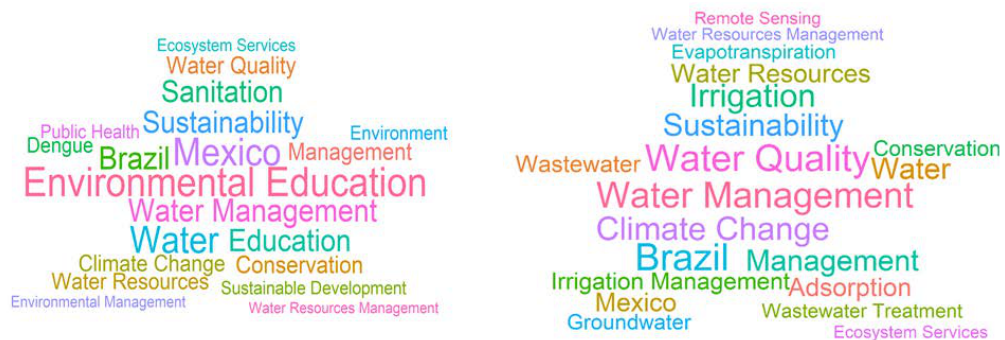
Figure 2. Word clouds of common key words for the Latin America and Caribbean (LAC) region’s publications on “water” and “management” and “education” and “water” and “management” from 1980 to 2019 with the size of the word proportionate to the number of times it occurred.